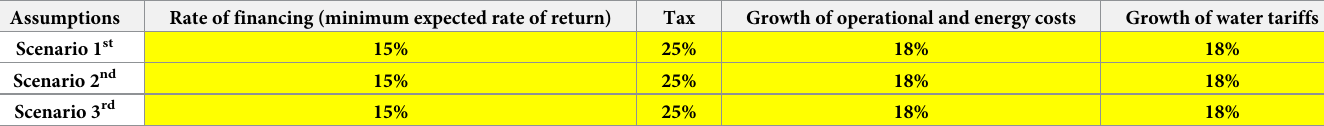
Table 8. The other criteria and the growth rates of operation costs and water tariffs. Assumptions Rate of financing (minimum expected rate of